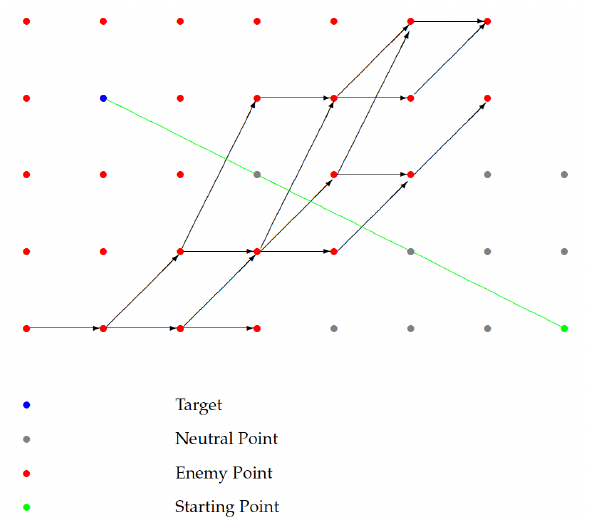
Figure 2. Example of a safe path (green line) according to the Tryhorn et al.